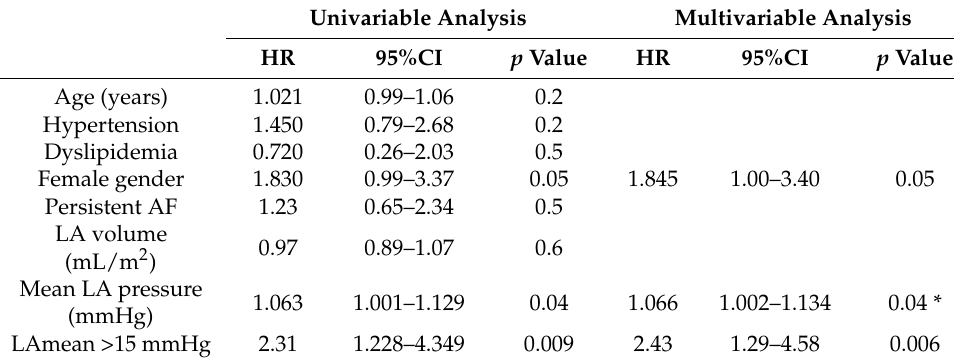
Table 4. Univariate and multivariate Cox regression analysis for AF recurrence.